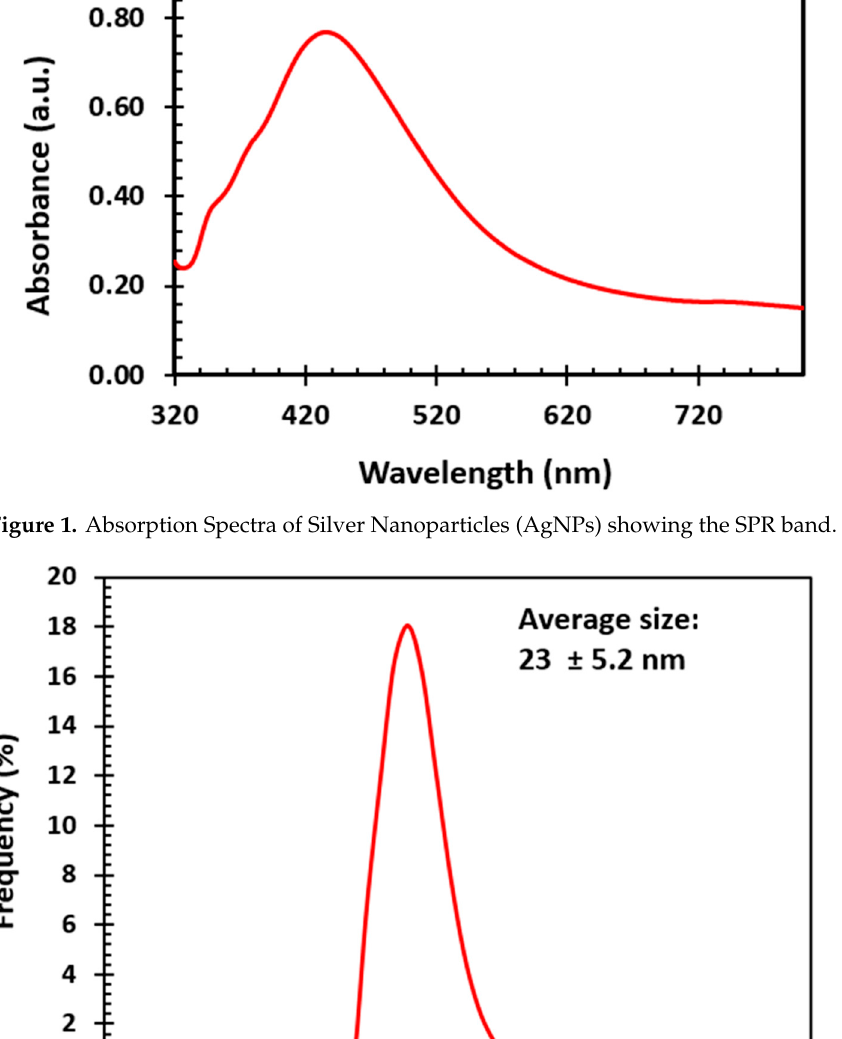
Figure 1. Absorption Spectra of Silver Nanoparticles (AgNPs) showing the SPR band.